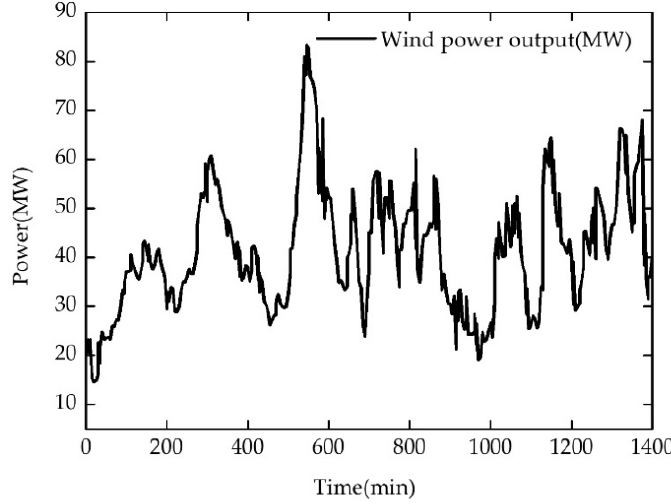
Figure 8. Wind power output curve.